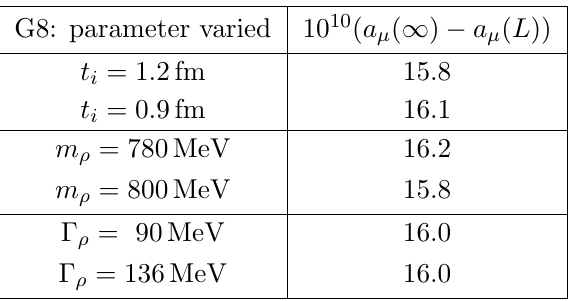
Table 11 . Change in the size of the (cid:12)nite-volume e(cid:11)ect under variations of the parameters. Only one parameter is varied at a time. The default values of the parameters are those given in table 9; they lead to a (cid:22) ( ) a (cid:22) ( L ) = 16 : 0 10 (cid:0) 10 (sum of column 4 and 5 in table 1 (cid:0) (cid:1)